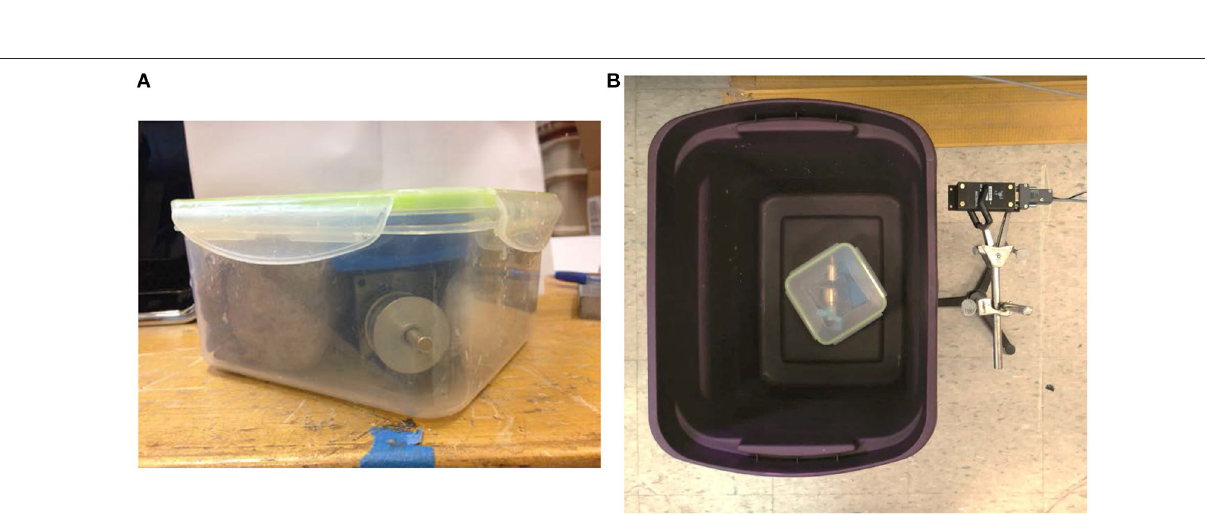
Frontiers in Built Environment | www.frontiersin.org